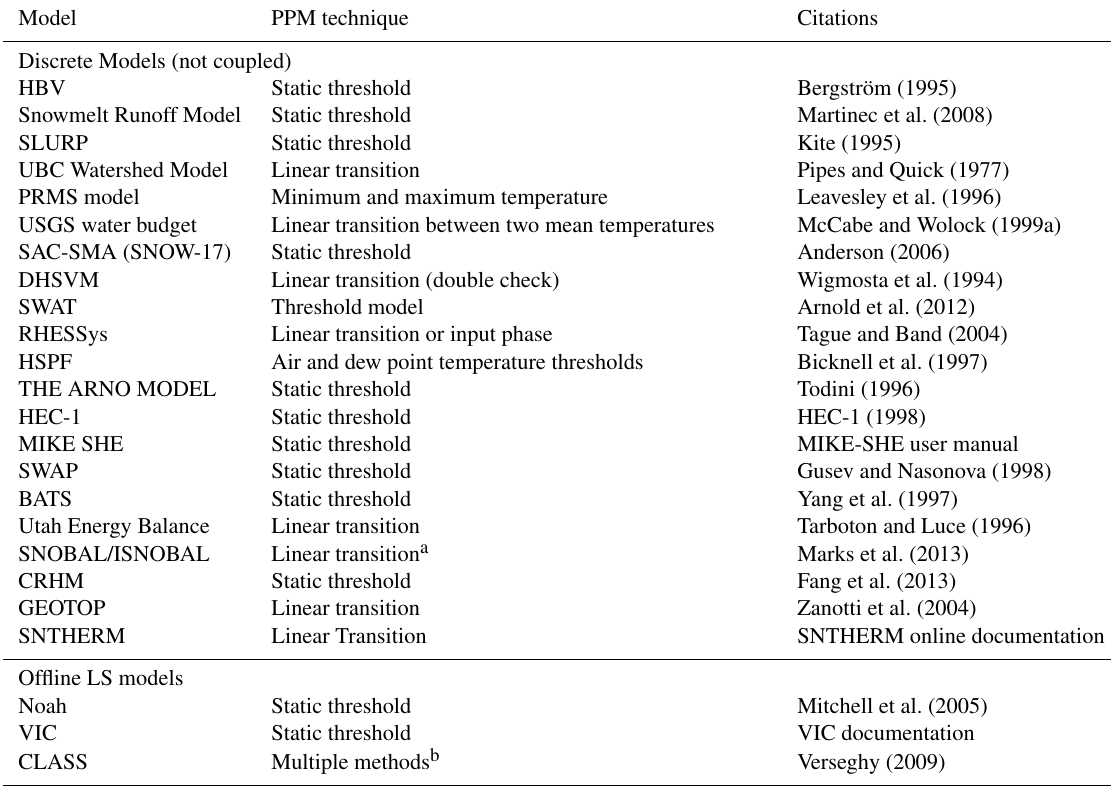
Table 2. Common hydrological models and the phase partitioning method (PPM) technique employed. The citation referring to the original publication of the model is